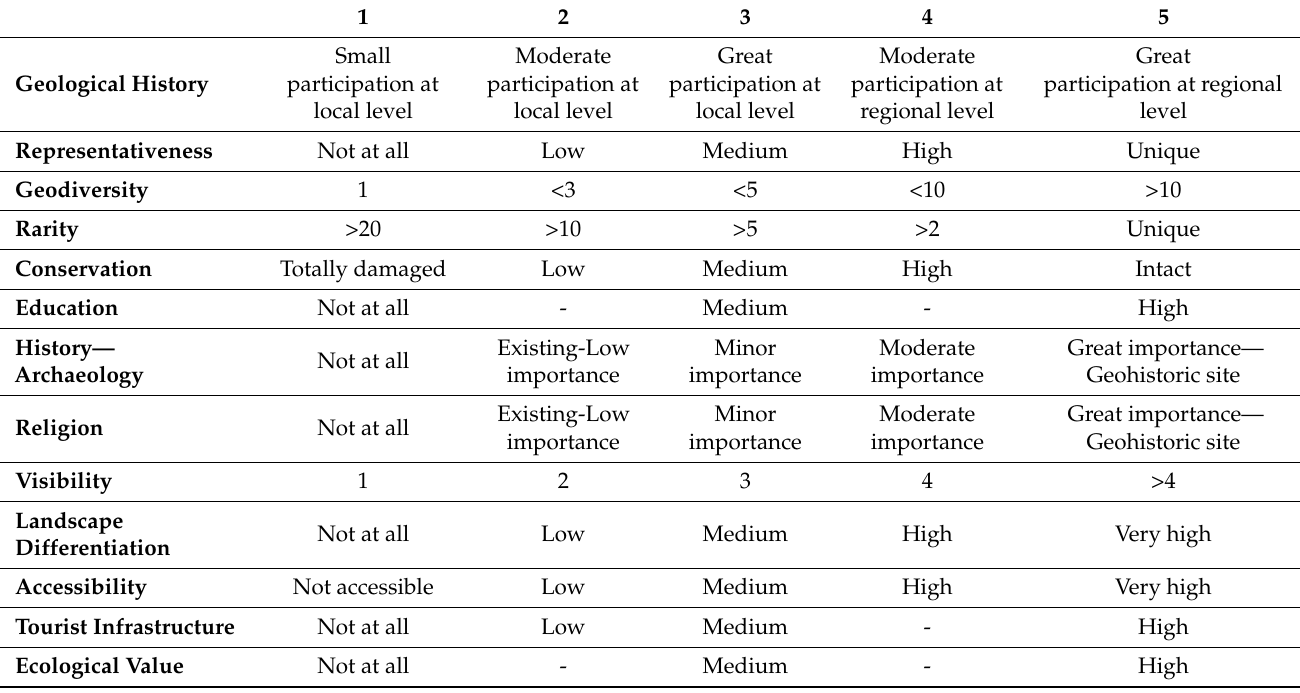
Table 1. Evaluation criteria for geosite assessment according to Skentos